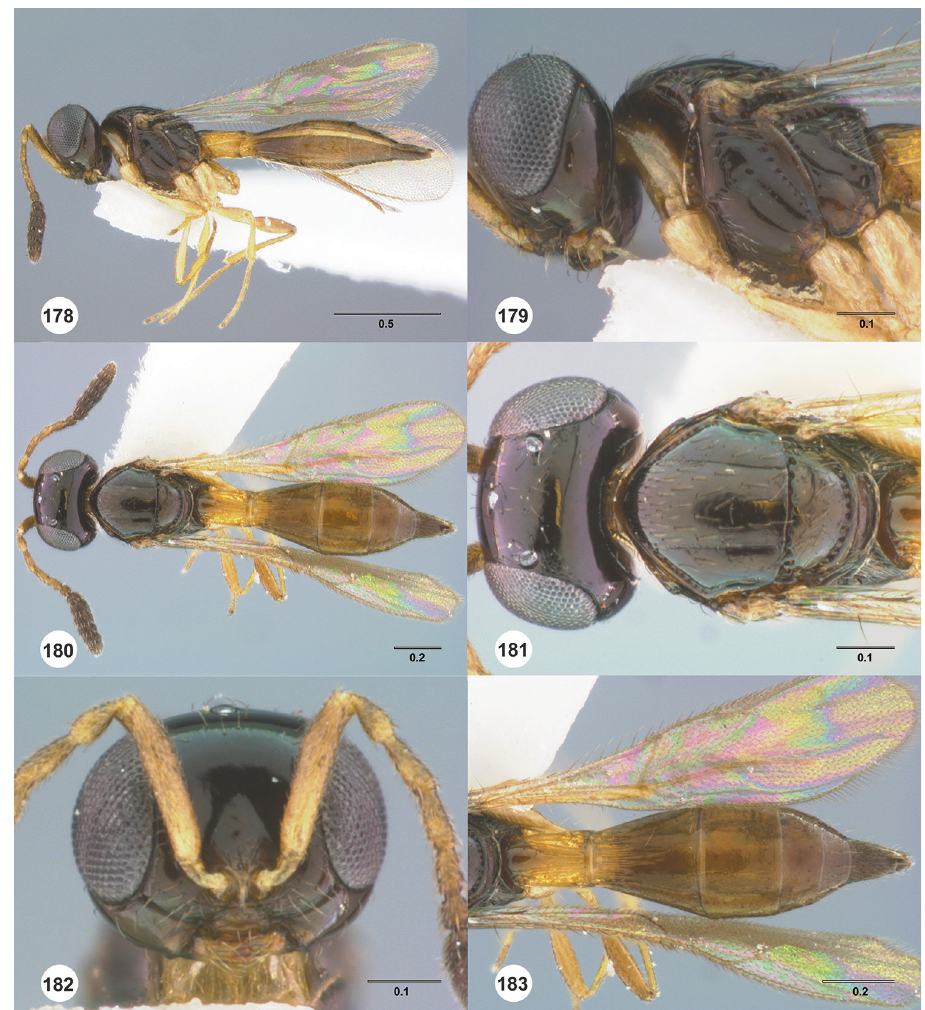
Figures 178–183. Calliscelio paraglaber sp. n., female, holotype (OSUC 532684). 178 Lateral habi- tus 179 Head and mesosoma, lateral view 180 Dorsal habitus 181 Head and mesosoma, dorsal view 182 Head, anterior view 183 Metasoma, dorsal view. Scale bars in millimeters. Color of metasoma in female: T1 yellow, otherwise dark brown to black. Color of metasoma in male: brown throughout. Horn on T1 in female: weakly developed. Sculpture of T1 horn dorsally: smooth. Sculpture of posterior margin of T1 in fe- male: longitudinally striate throughout. Sculpture of T1 in male: longitudinally stri- ate. Development of longitudinal striae on T2 in female: reaching the middle of T2 medially; reaching posterior margin of T2. Sculpture of T3: smooth with longitudinal submedian striae. Shape of T6 in female: short, slightly longer than wide. Sculpture of S3: largely smooth with sparse and fine